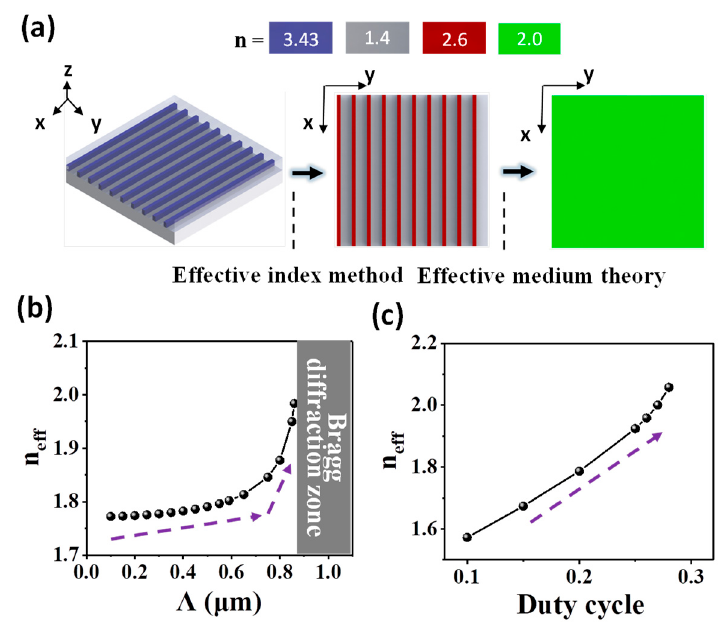
Figure 2. ( a ) The method to obtain the effective RI n eff of the equivalent homogeneous material of SWG. The effective index method is firstly used to compress the 3D SWG (left) to a 2D SWG (middle) by reducing the z dimension. Then the effective RI n eff of the equivalent homogeneous material (right) is derived by the effective medium theory. ( b ) The dependence of n eff on Λ at 3.62 µm when duty cycle = 0.25. ( c ) The dependence of n eff on duty cycle at 3.62 µm when Λ = 0.86 µm.